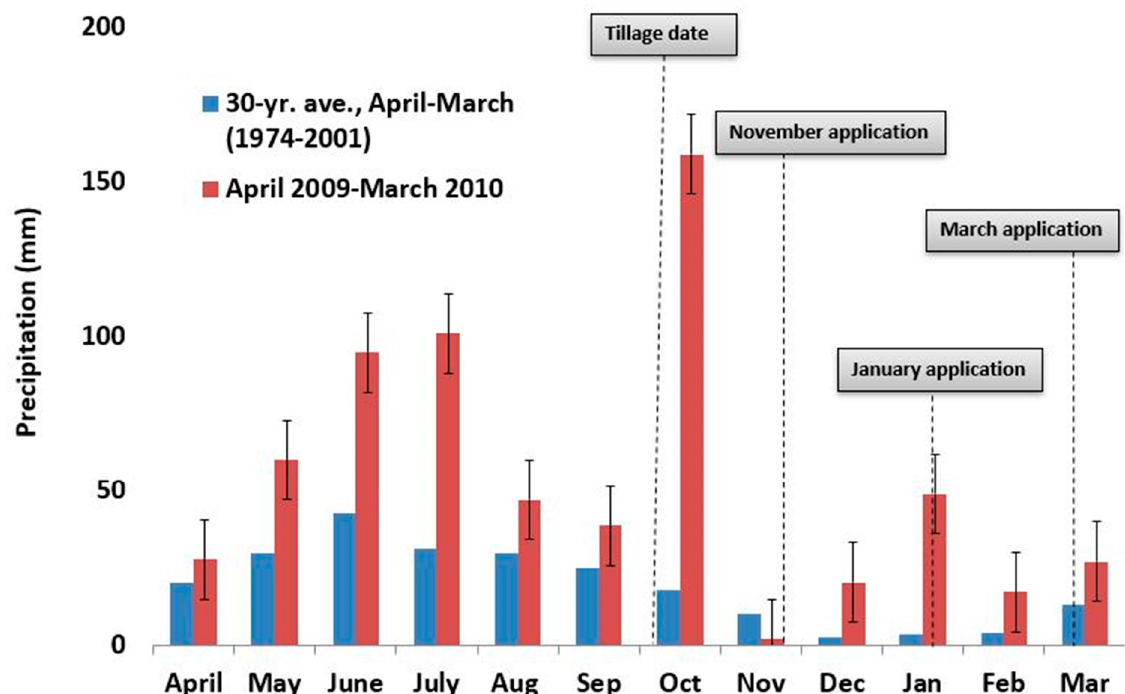
Figure 3. Precipitation data by month, Brookings, SD. (28 November 2009, 28 January 2009, and 4 March 2010 were the first, second, and third manure application dates, respectively; 11–17 March 2010 was the runoff collection date). The bars indicate standard errors. Table 3. Average soil moisture, temperature, snow depth, and total snow accumulation during manure application dates; Brookings, SD.